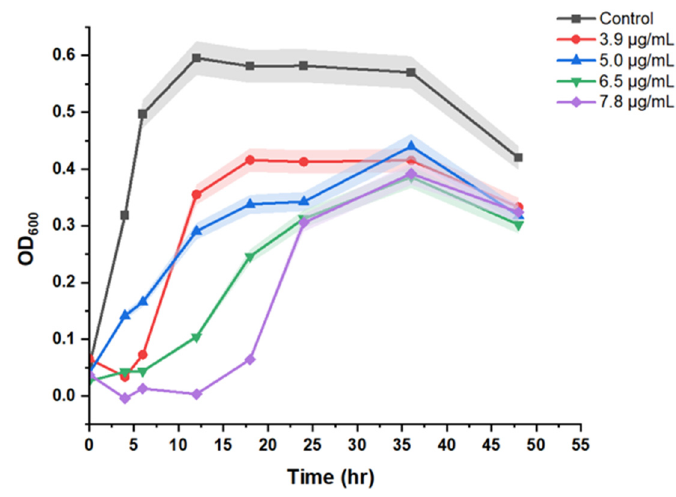
Figure 3. Growth pattern comparing sensitive and resistant strains.